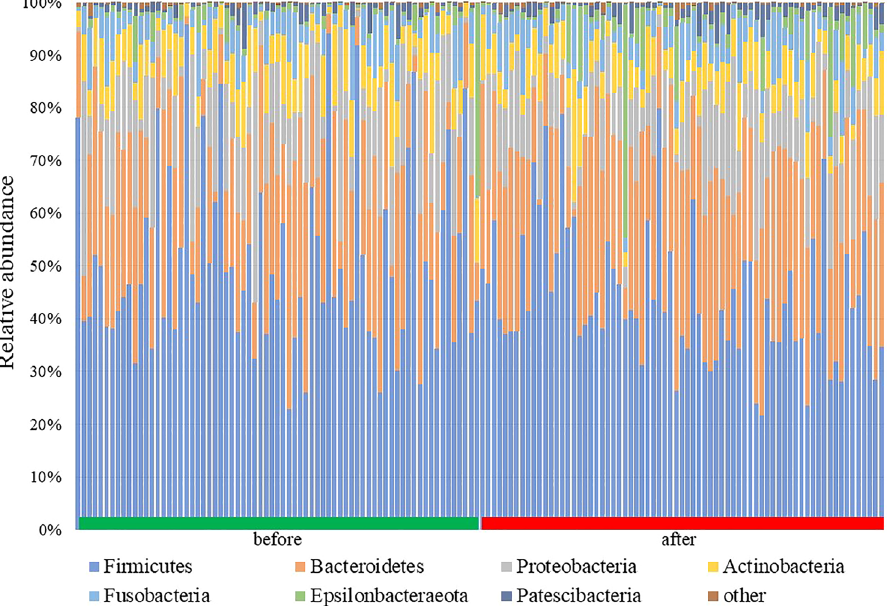
Figure 2. Taxonomic composition of the gastric microbiota before and after distal gastrectoy (DG) at the phylum level. The predominant bacteria (> 5% of the total sequences in either group) at the phylum level included Firmicutes, Bacteroidetes, Proteobacteria, and Actinobacteria, which comprised 91.4% and 88.3% of the gastric microbiota before and after DG, respectively.